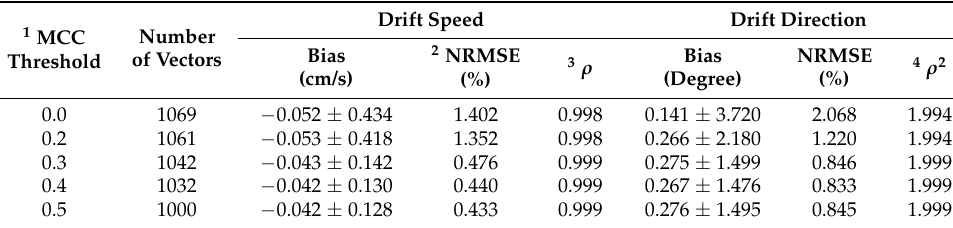
Figure 5. Comparison of the drift vectors derived from KOMPSAT-5 and SVP buoys. ( a ) Scatter plot of the drift speed. Black line is the identity and regression line, and the color represents maximum cross correlation of the pattern matching result. ( b ) Histogram of the difference in drift direction. The y -axis is in log scale. Table 2. Accuracy evaluation results of the KOMPSAT-5-derived sea ice drift vectors.